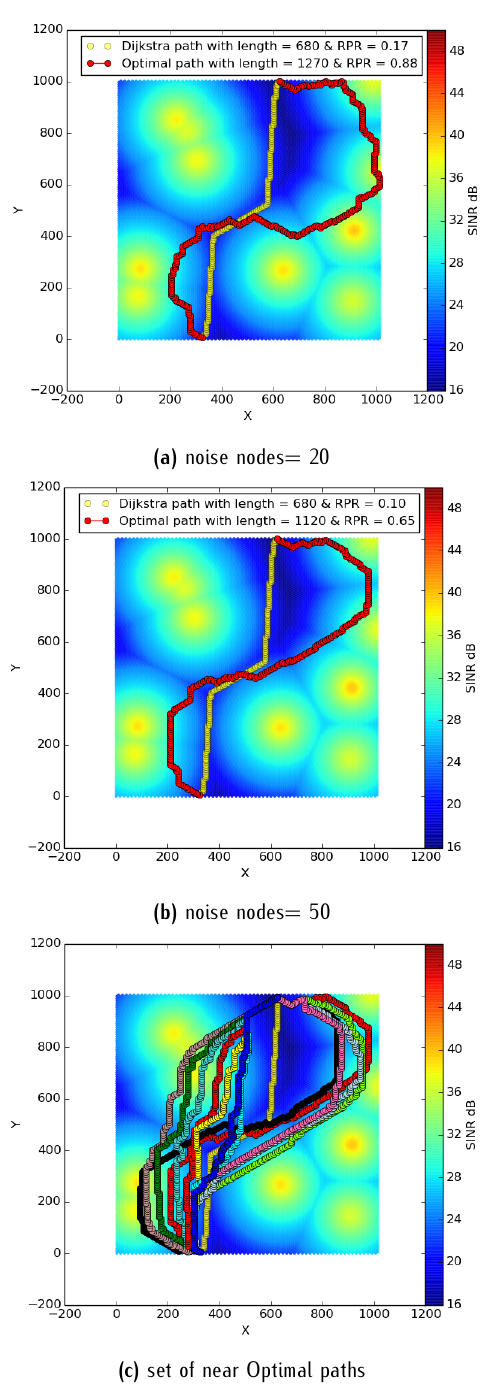
Figure 11. Optimal and near optimal paths, h =60m